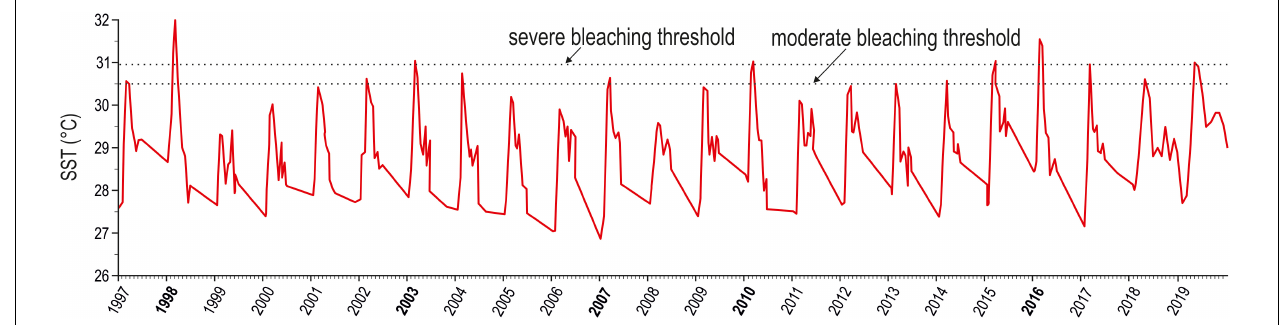
FIGURE 1 | Twenty-three year trend (1997–2019) of maximum monthly sea surface temperature (SST, red solid line). Bold values on the x axis correspond to years when bleaching events have been reported for the Maldives (from Morri et al., 2015, and references therein; NOAA, 2016). The threshold temperatures triggering moderate and severe bleaching events are also indicated (according to NOAA, 2016 and Montefalcone et al., 2018a).